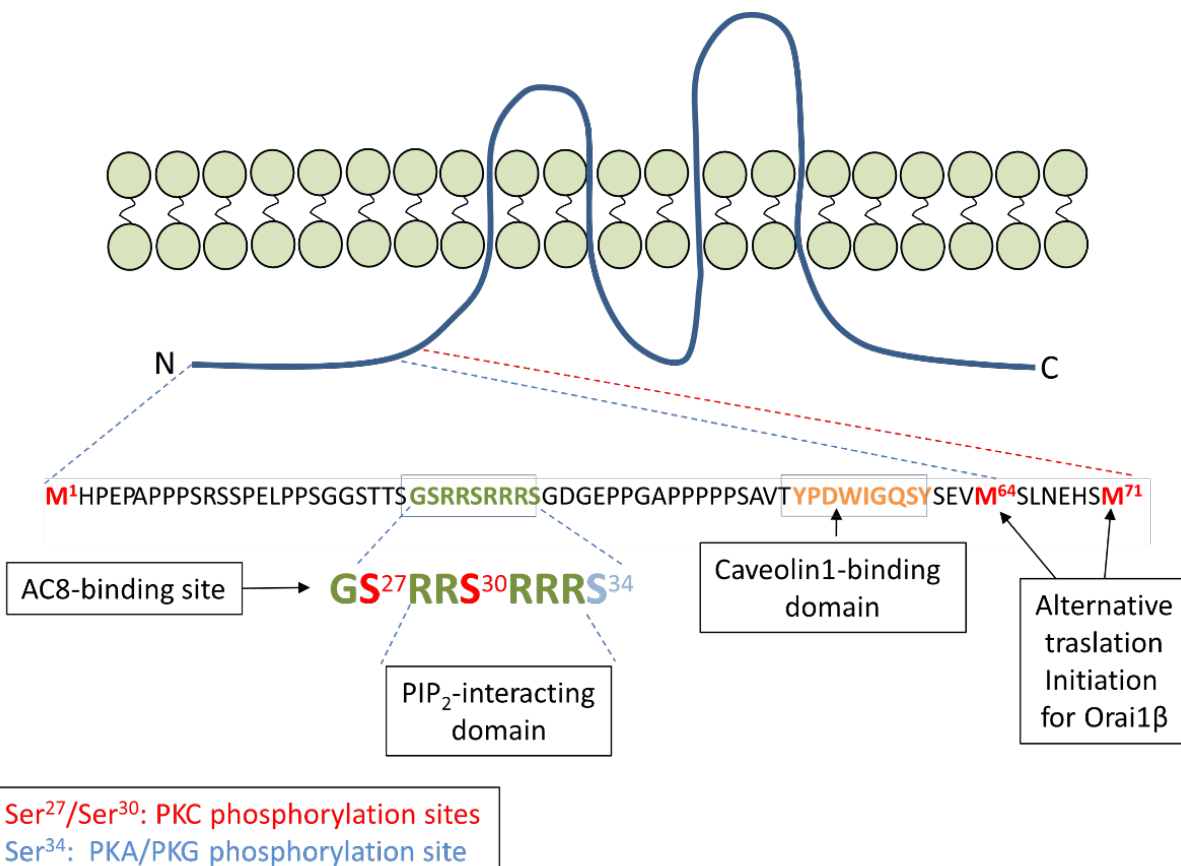
Figure 1. Amino acid sequence of the N-terminal region unique to Orai1 α . Within the 63 or 70 residues unique for the N-terminal region of Orai1 α there are several functional domains, including one of the caveolin1-binding domains and the AC8-binding site, which overlap with the PIP 2 -interacting region and the PKC and PKA/PKG phosphorylation sites (serines 27, 30 and 34, respec- tively).